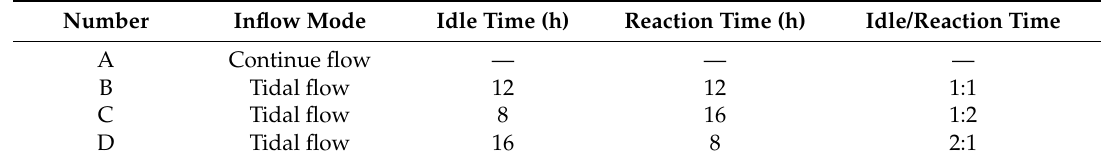
Table 2. Time settings of the different water inputs to the TF-CW